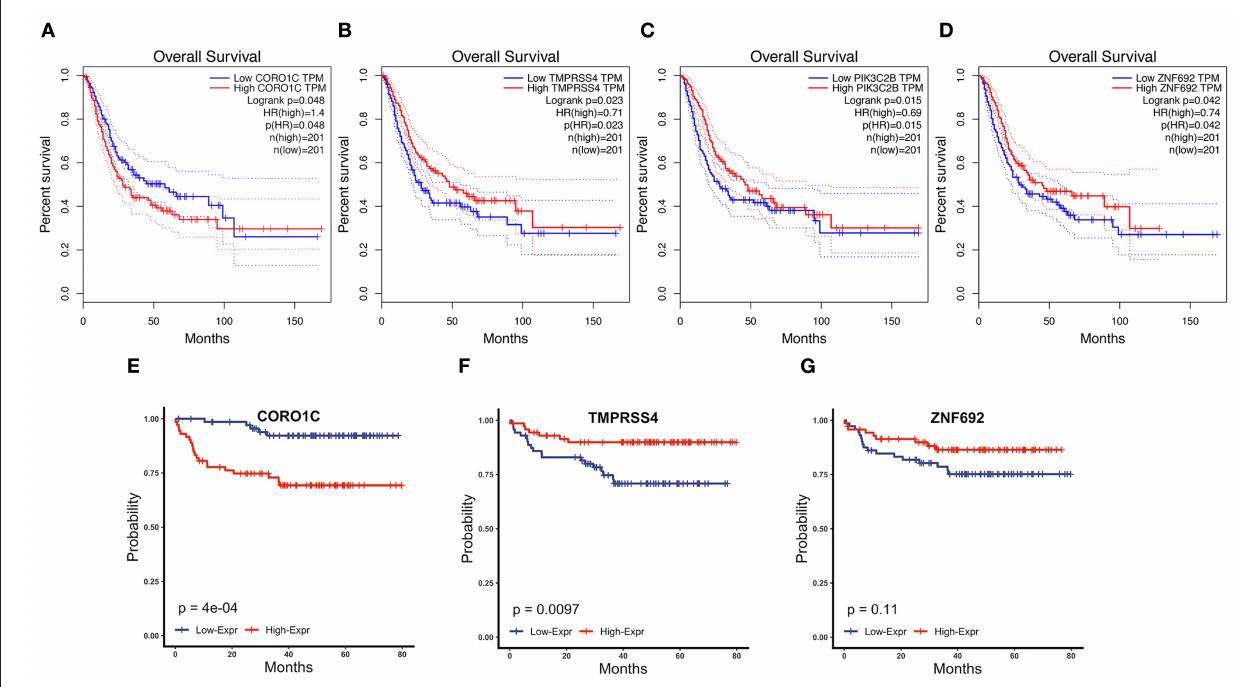
FIGURE 4 | Survival analysis of four candidate hub genes in TCGA-BLCA and GSE19915 data. (A–D) Survival analysis result of CORO1C (A) , TMPRSS4 (B) , PIK3C2B (C) , and ZNF692 (D) in TCGA-BLCA downloaded from GEPIA. (E–G) Survival analysis of CORO1C (E) , TMPRSS4 (F) , and ZNF692 (G) in GSE19915.